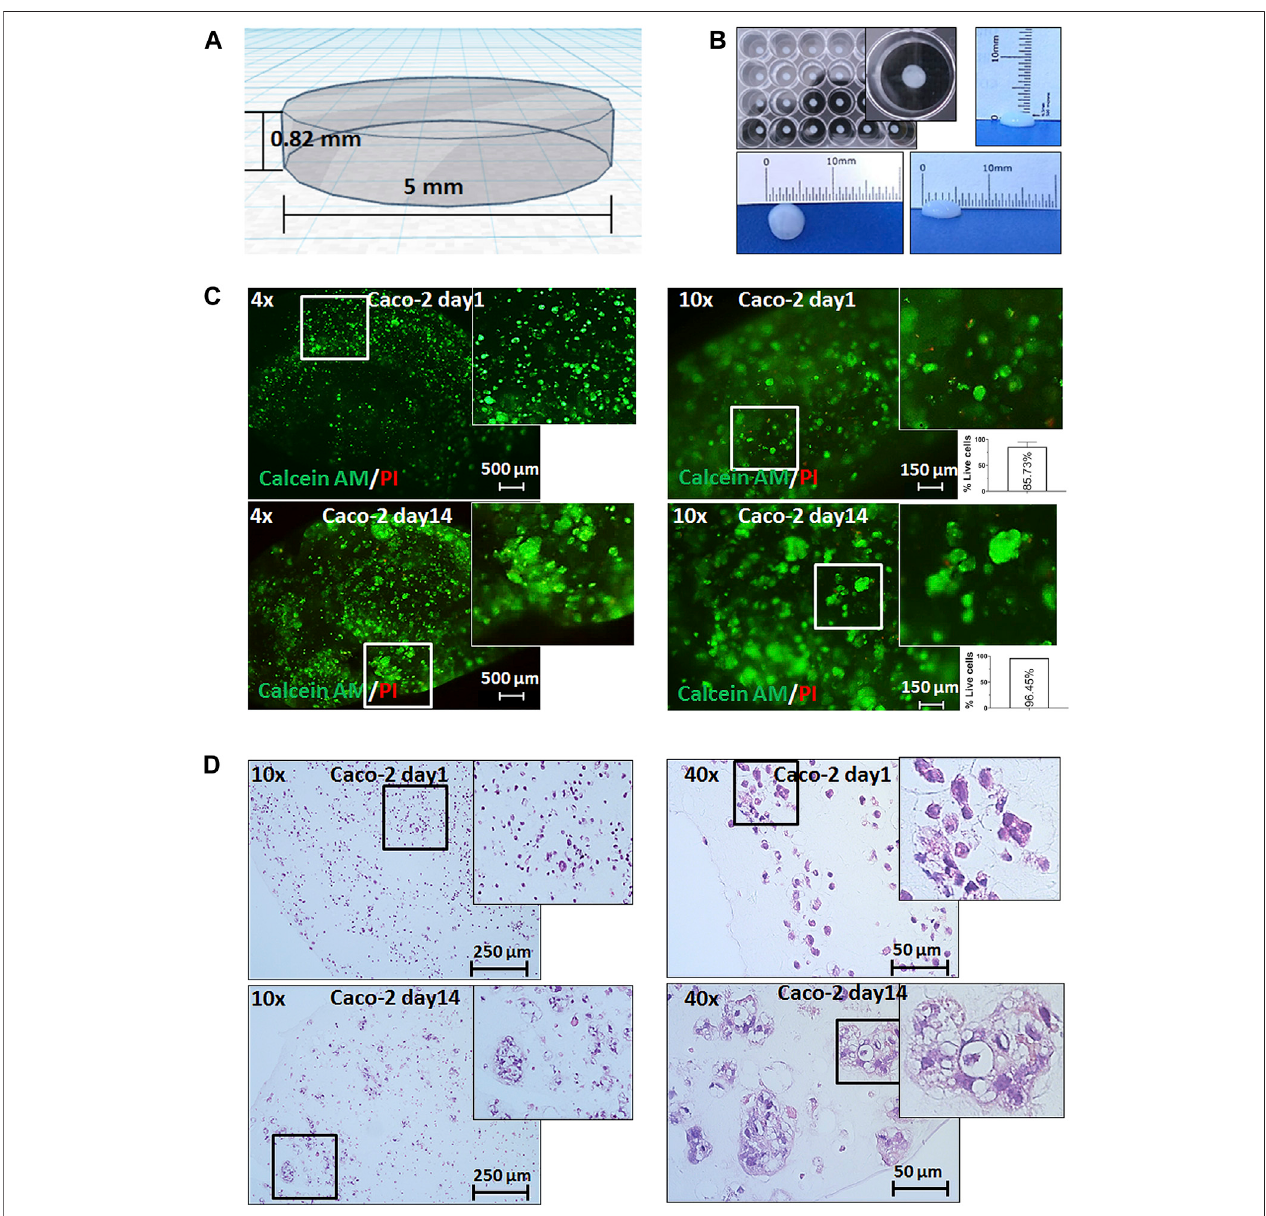
FIGURE 1 | 3D bioprinting of Caco-2 cells. (A) Computer-aided design (CAD) of the developed 3D bioprinting model. (B) Representative macroscopic image of 3D bioprinted cells in a 24-well plate showing the reproducibility and uniformity of prints (with the growth medium) and of the size of a 3D bioprint. (C) Live/dead staining with calceinAM(green fl uorescence)forlivecellsandpropidiumiodide(PI-red fl uorescence)fordeadcellsonday1andday14afterprintingundermagni fi cationsasshown,and relativequanti fi cationofpercentagelivecells(per1 mm 2 ).ErrorbarsrepresentSDofthemeanfromatleasttwoimages. (D) Hematoxylinandeosin(H&E)stainingof3D bioprinted Caco-2 cells on day 1 and day 14 with magni fi cations as annotated showing the formation of tumor-like morphological structures of cells at day 14.